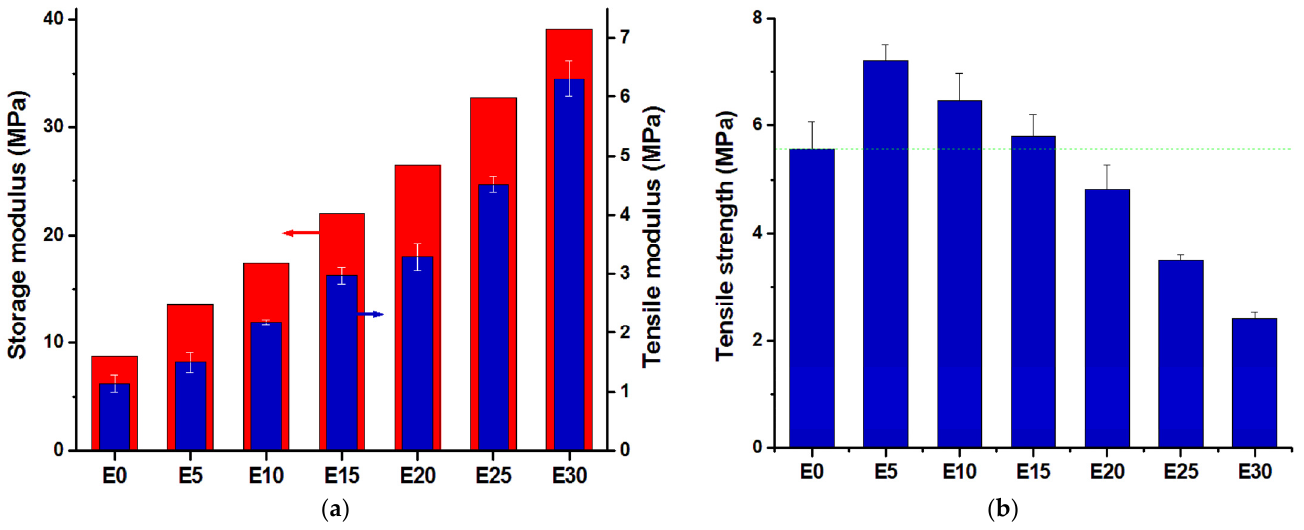
Figure 5. Tensile modulus and storage modulus of nanocomposites at 30 °C ( a ); tensile strength of nanocomposites ( b ).